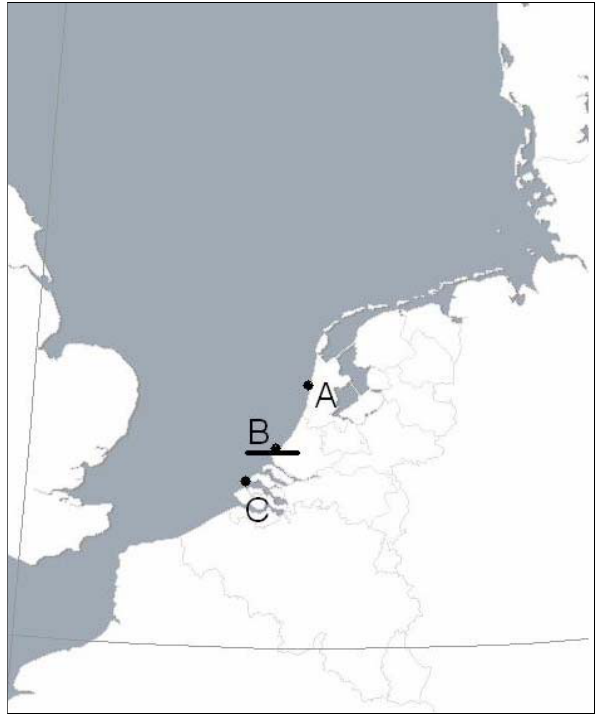
Fig. 3. Map of domain 1 and the inner domain. Domain 1 covers the area between Scotland (northwest part of the map), southern Swe- den (northeast part of the map) and northern France (southern part of the map). The inner domain covers The Netherlands, Belgium, Luxemburg, a large part of the North Sea and small part of eastern England, northern France and